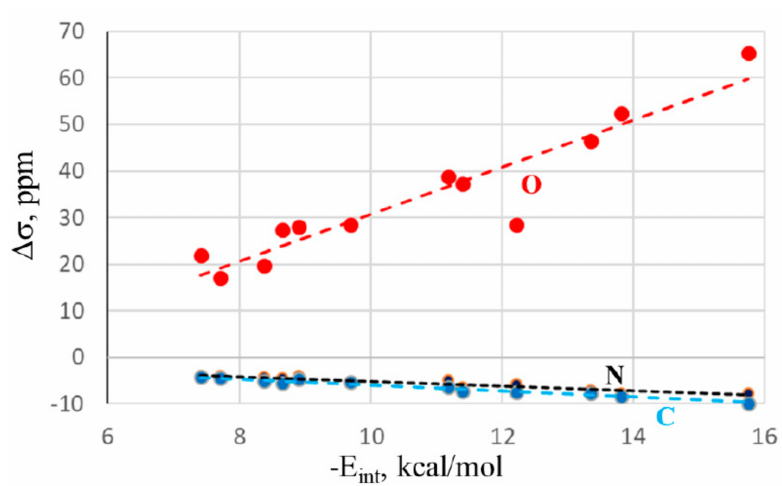
Figure 4. Relationship between MP2 / aug-cc-pVDZ interaction energy and changes in NMR shielding of indicated atoms of NMA. Broken lines indicate linear